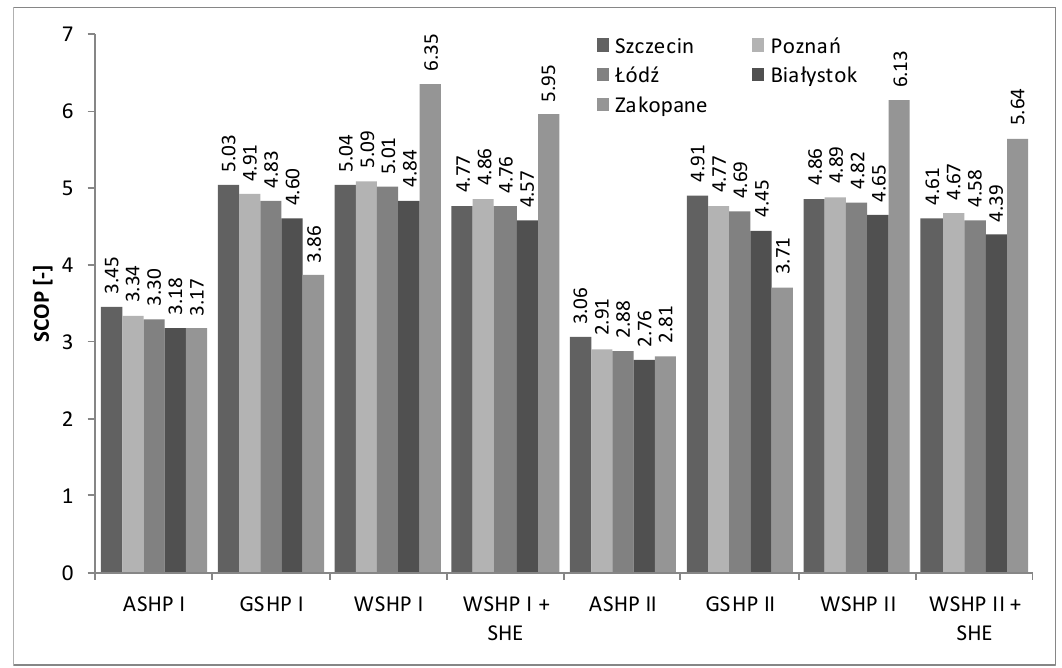
Figure 4. SCOP net values in each climatic zone in Poland in the variants I and II.